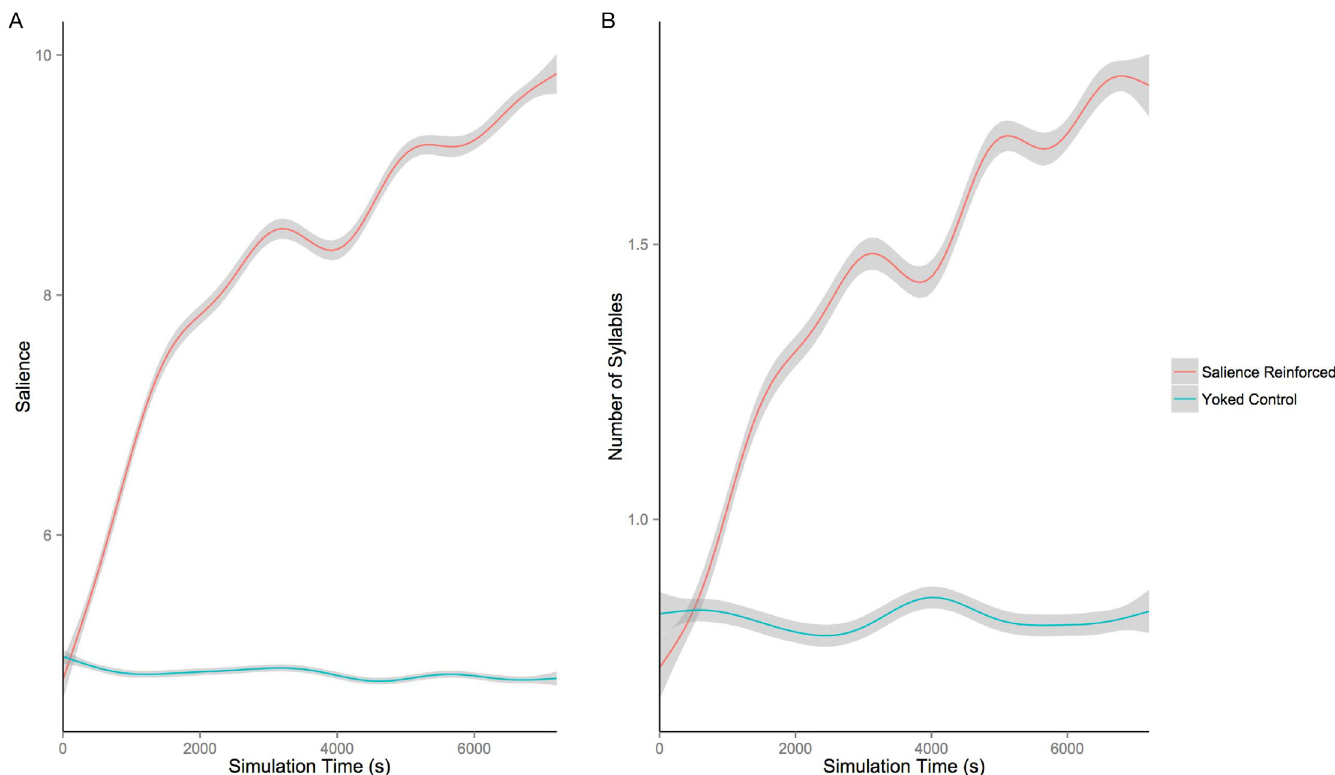
Fig 3. Increase in salience and syllabicity over time. A: Average auditory salience of the sounds produced by the model as a function of simulation time in seconds and whether the simulation was reinforced based on auditory salience or was a yoked control. B: Number of vowel nuclei, i.e. number of syllables, estimated to be contained within the sounds produced by the model as a function of simulation time in seconds and whether the simulation was reinforced based on auditory salience or was a yoked control. Lines are generalized additive model fits and dark gray shading gives 95% confidence intervals around those fits. When reinforced for auditory salience, the model increases both the salience of its vocalizations and the number of syllables contained within those vocalizations, while the yoked controls do not show such